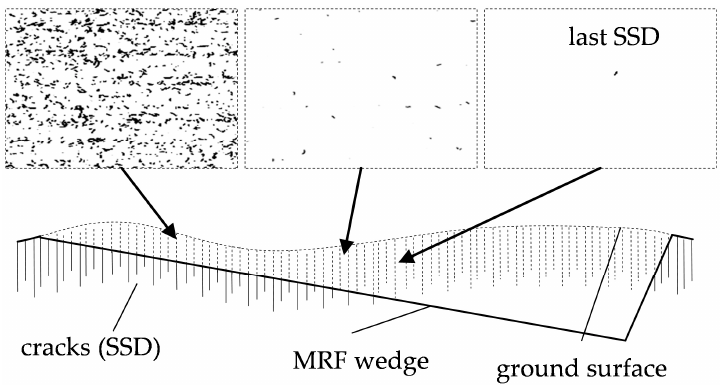
Figure 6. Sketch of subsurface damage (SSD) appearance along the MRF wedge.